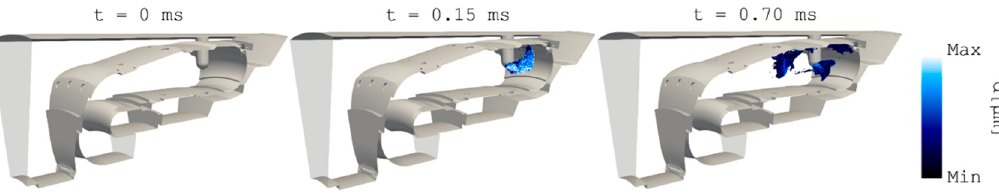
Figure 16. Sequence of snapshots of the Lagrangian particle cloud after the start of injection. The Lagrangian particle cloud is colored by the diameter, d p